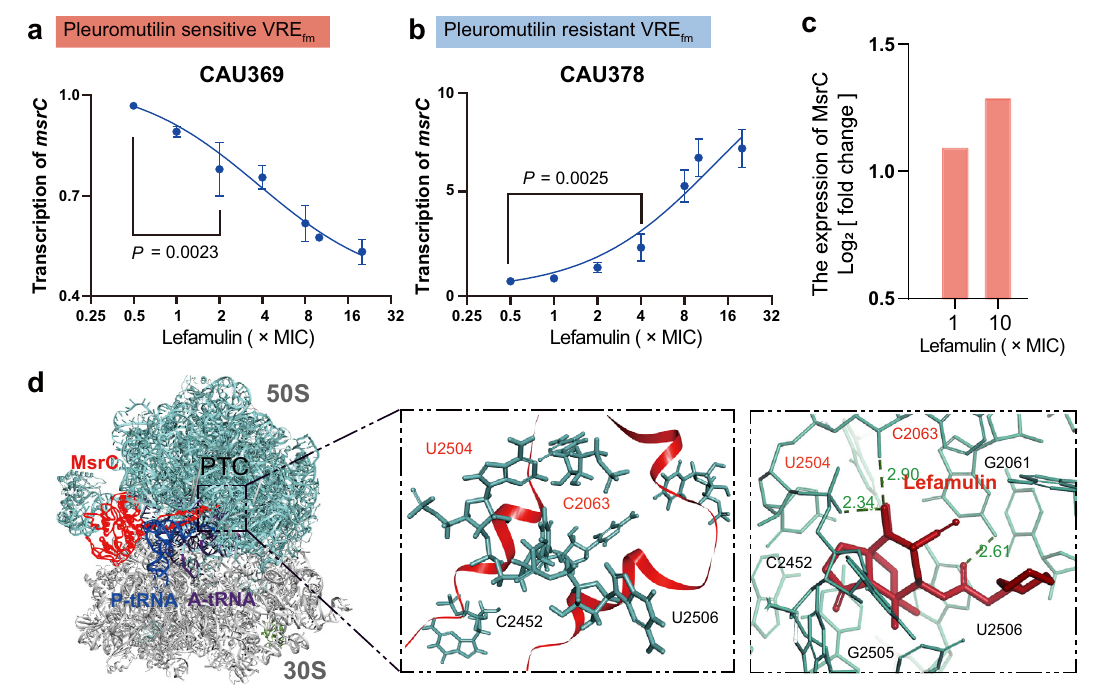
Fig. 3 Low expression of msrC is linked with collateral sensitivity. a – b Transcription analysis of msrC in pleuromutilin-sensitive VRE fm CAU369 ( a ) and pleuromutilin-resistant VRE fm CAU378 ( b ). c Proteomics analysis of VRE fm CAU378 treated with 1× and 10 × MIC lefamulin for 1 h. Proteins were identi fi ed as signi fi cantly different with fold changes of log 2 [fold changes] values of at fold-increase or fold-decrease of expression levels. d Comparison of lefamulin binding sites within the MsrC-ribosome complex. The 50S (green) and 30S (gray) subunits (PDB 5AA0 [https://www.rcsb.org/structure/5AA0]), and the A-site tRNA (purple) and P-site tRNA (blue) are shown. Binding of MsrC (red, homology of the template with PDB 5ZLU [https://www.rcsb.org/ structure/5ZLU], middle) blocks the binding of lefamulin (brick-red, PDB 5HL7 [https://www.rcsb.org/structure/5HL7], right) to PTC in the 50S subunit. Data were presented as means ± S.D. n.s., not signi fi cant, determined by non-parametric one-way ANOVA ( n =